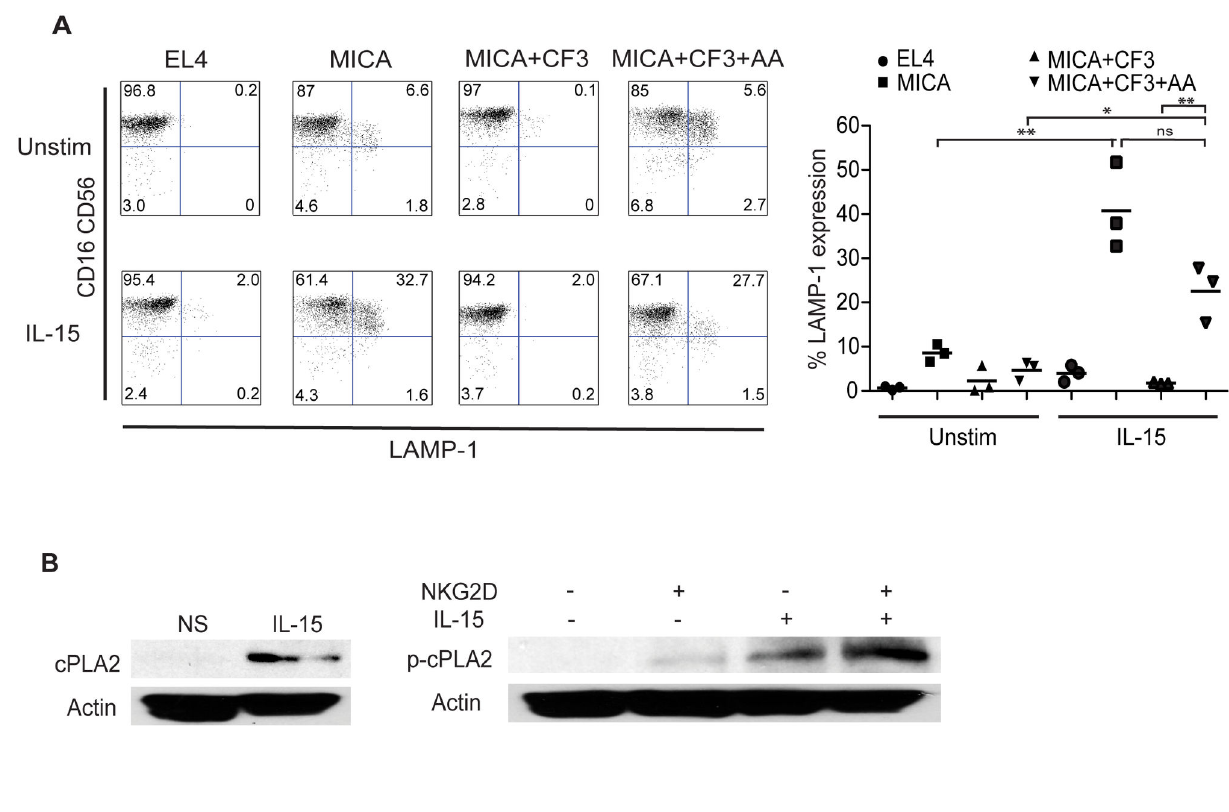
Figure 2. Freshly isolated blood NK cells require an additional signal to lyse targets efficiently through NKG2D. ( A ) Peripheral blood NK cells fail to kill via NKG2D in the absence of IL-15, but upon stimulation with 10 ng/mL IL-15 they are able to lyse targets in a cPLA2-dependent manner. Blood NK cells from healthy controls were isolated by negative selection and are gated on a CD3 - CD94 + background. FACS plots are representative of three independent experiments, summarized on the right. ( B ) Blood NK cells upregulate cPLA2 basally and are primed to activate cPLA2 more robustly upon activation of NKG2D. Peripheral blood NK cells isolated from healthy controls were stimulated overnight with IL-15 and/or an anti-NKG2D mAb for four hours where indicated, then probed for cPLA2 (left) or phospho-cPLA2 (right). Data are representative of three independent